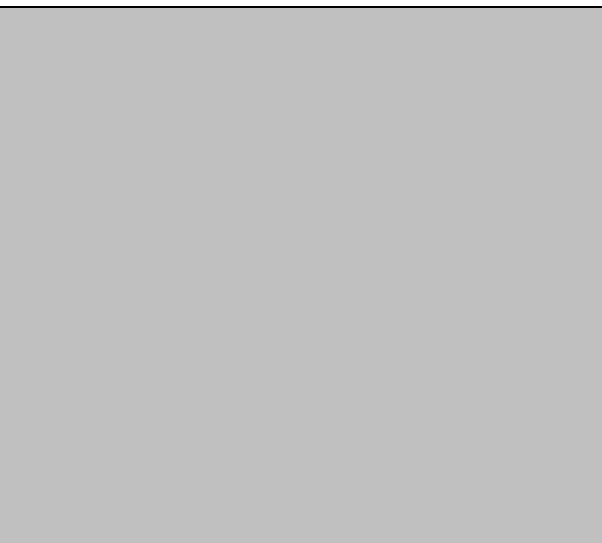
Table VI : Information about mental